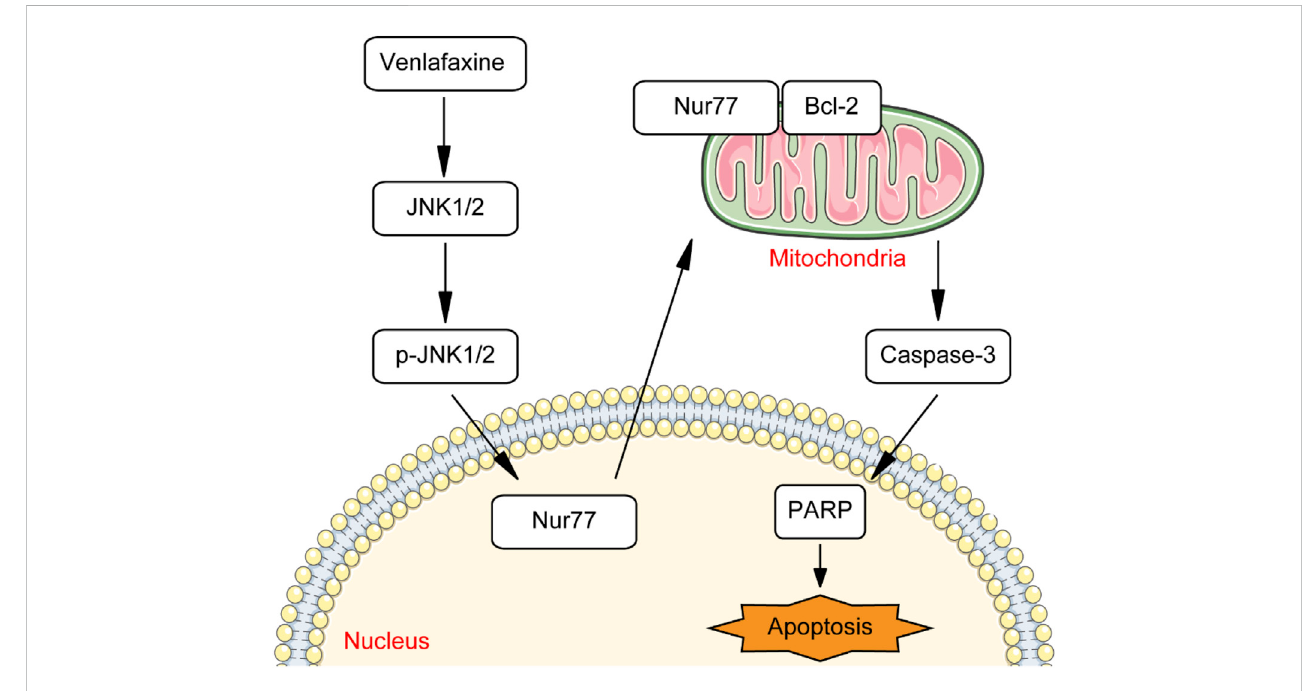
FIGURE 8 Schematic summary of venlafaxine mediated signaling